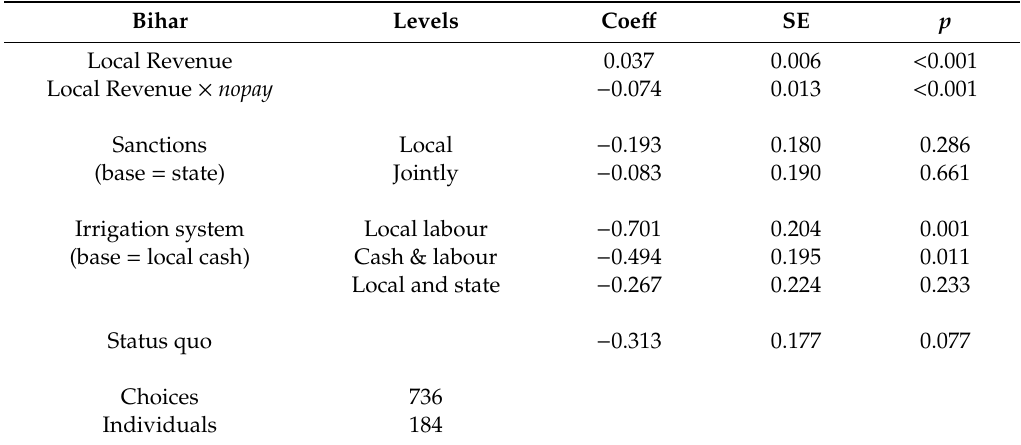
Table 11. Conditional logit estimates for preferences for governance structures: